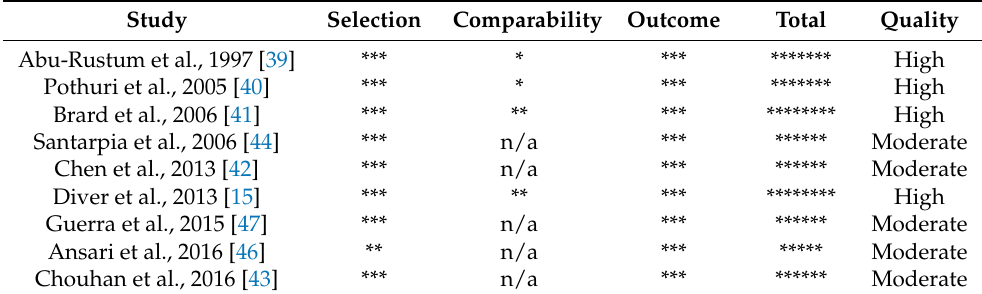
Table 4. Quality assessment of nonrandomized studies using the modified Newcastle-Ottawa scale (NOS).